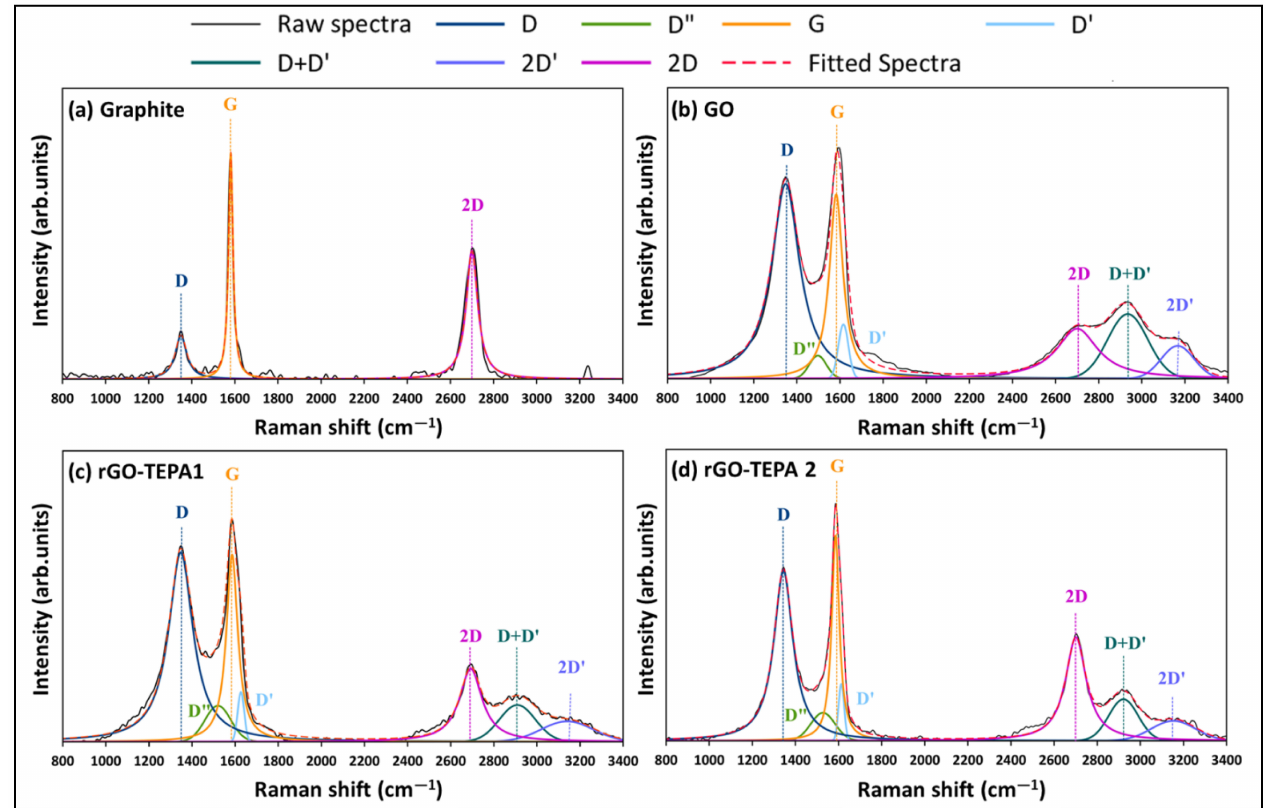
Figure 4. The deconvolution and peak fitting of the Raman spectra of ( a ) graphite, ( b ) pristine GO,